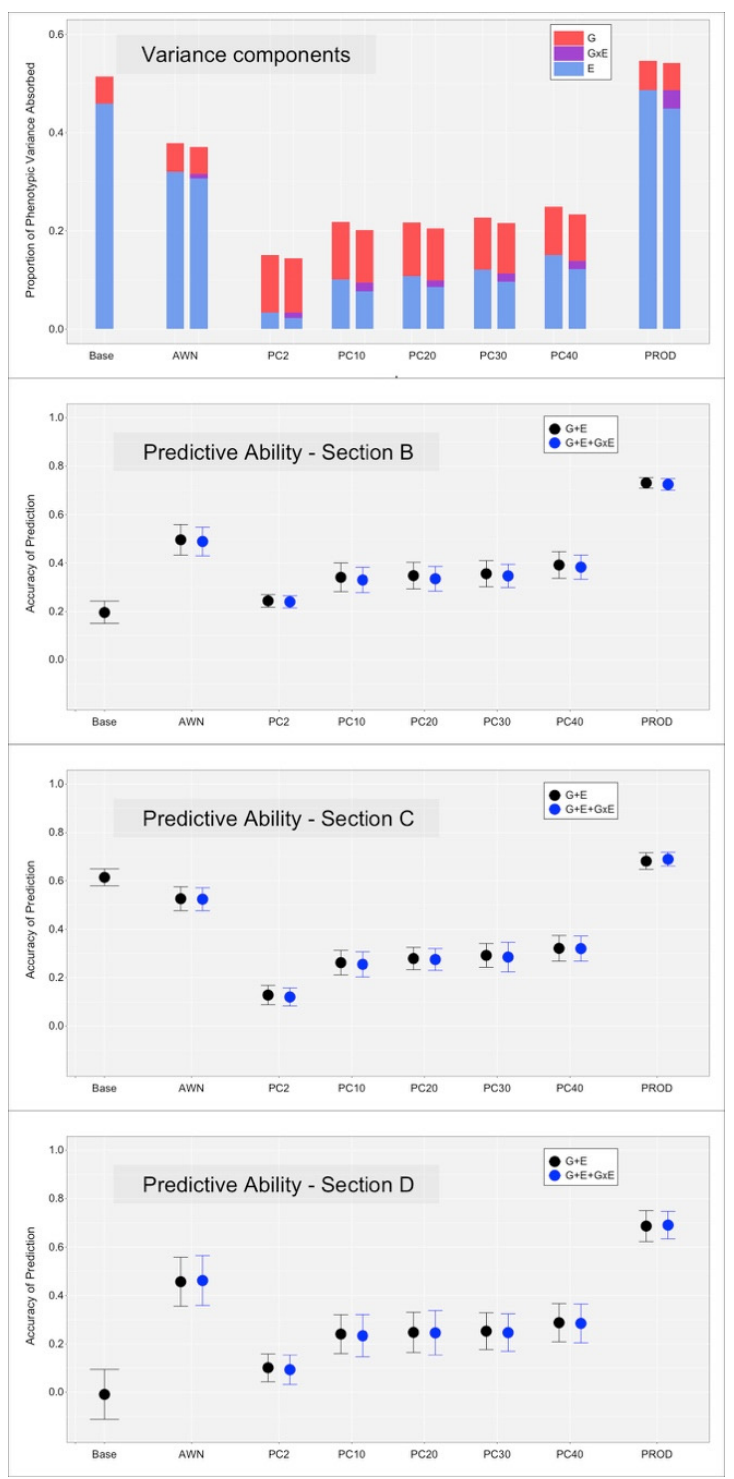
Figure 3. Proportion of variance components explained by the additive genetic effect (G), environ- mental effect (E) and their interaction (GxE) term, together with predictive ability of the respective models under the different scenarios for milk yield (MY). The black dots (and bars) refer to the models that included the G and E terms; the blue dots (and bars) refer to the models that included the G, E, and GxE terms.